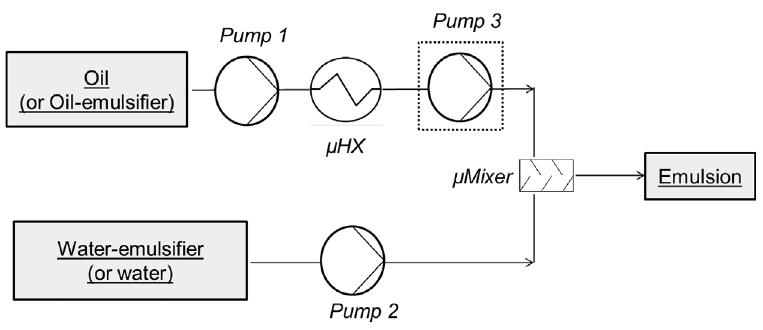
Figure 4 Preliminary designed flow diagram for continuous